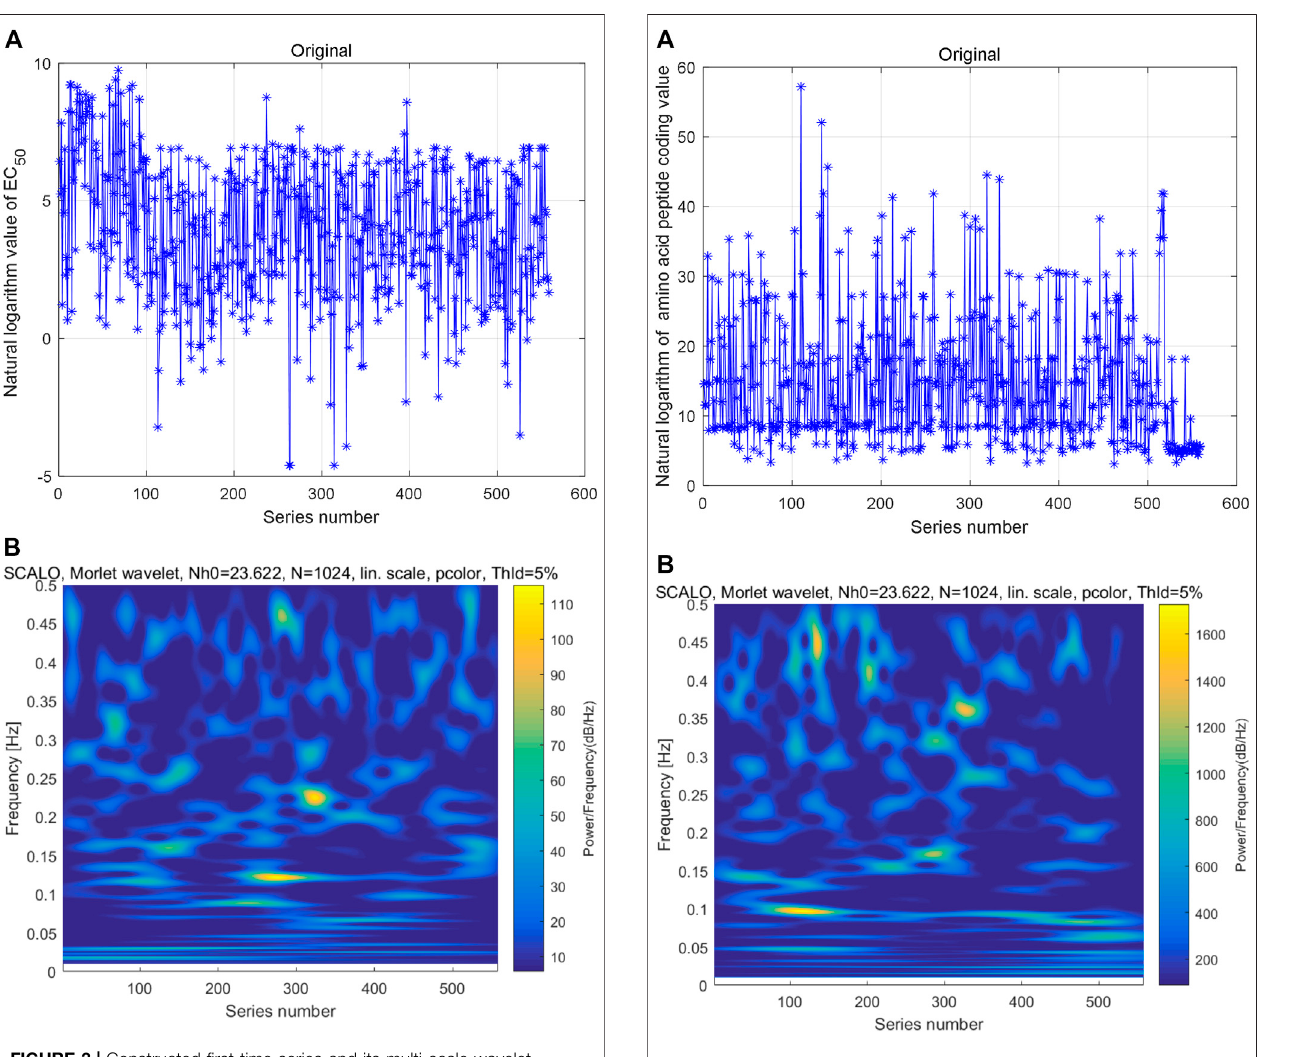
FIGURE 4 | Constructed second time series and its multi-scale wavelet transform: (A) time series of natural logarithm of coding AAS and (B) time – frequency distribution of multi-scale wavelet